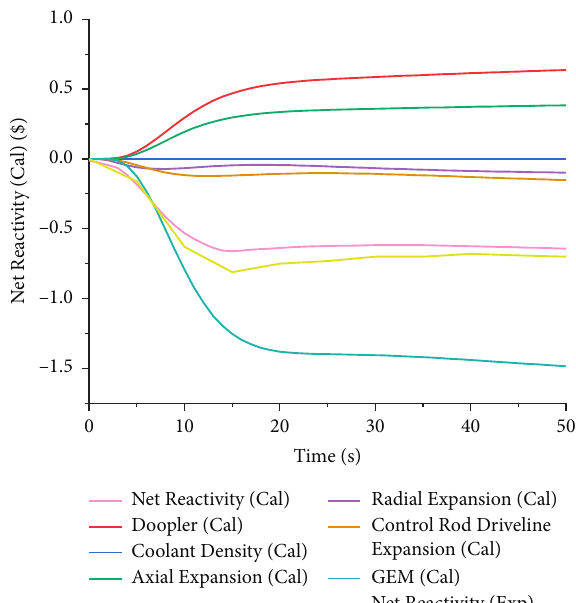
Figure 20: Reactivity Transient Profile of FFTF LOFWOS test #13 (0s–50 s).